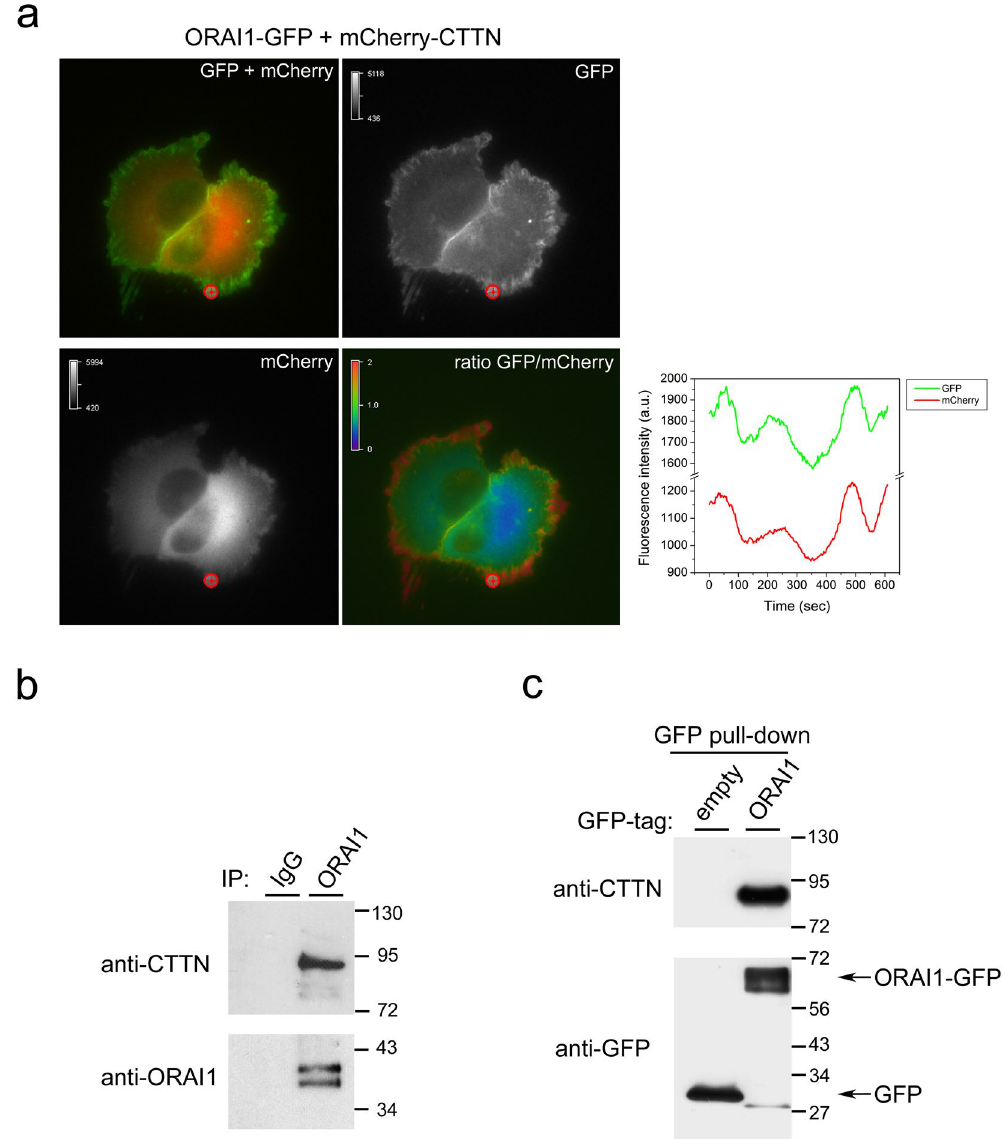
Figure 7. ORAI1-CTTN co-localization and co-precipitation. ( a ) U2OS wild-type cells were transfected for the transient expression of ORAI1-GFP/mCherry-CTTN and monitored for both tags in Leibovitz’s L-15 medium supplemented with 10% FBS. Emission of fluorescence was recorded every 3 sec for 10 min, and images were split in both channels (GFP and mCherry). The GFP/mCherry ratio was calculated from single channels, and is shown on a pseudocolor scale (ratio values 0–2). A selected area was assessed for the variation of fluorescence intensity, shown in the line graph. The full time-lapse sequence is given in Supplementary Movie 8. ( b ) Endogenous ORAI1 was immunoprecipitated with an anti-ORAI1 antibody conjugated to agarose beads (lane 2). The level of immunoprecipitated ORAI1 was assessed with an anti-ORAI1 antibody (bottom panel), and the level of co-immunoprecipitated CTTN was evaluated with an anti-CTTN antibody (top panel). As a negative control, lysates from the same experimental conditions were incubated with preimmune serum and agarose beads (lane 1). Blots are representative of 3 independent experiments with 3 different cultures. ( c ) U2OS cells transiently expressing GFP (lane 1) or ORAI1-GFP (lane 2) were lysed to pull-down GFP-tagged ORAI1 with GFP-Trap beads. The level of endogenous CTTN bound to ORAI1-GFP was evaluated by immunoblot using an anti-CTTN antibody (top panel), and the level of pulled-down GFP or ORAI1-GFP was evaluated with an anti- GFP antibody (bottom panel). Blots are representative of 4 independent experiments with 4 different